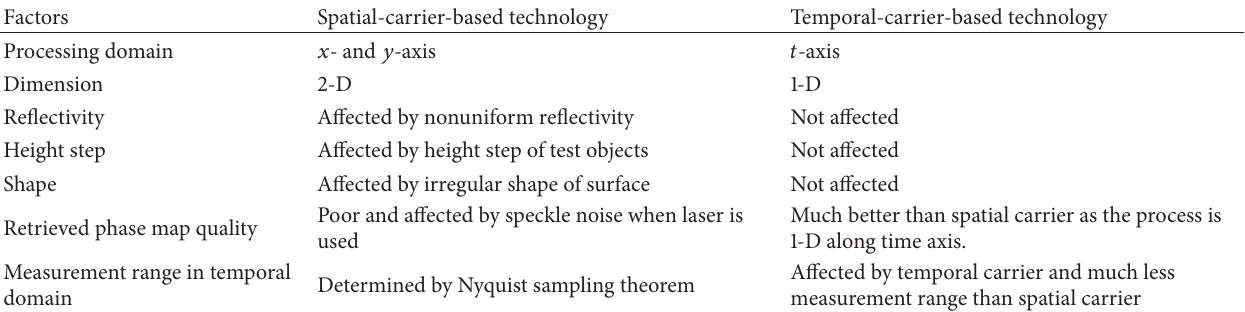
Table 1: Comparison of spatial-carrier and temporal-carrier-based techniques in